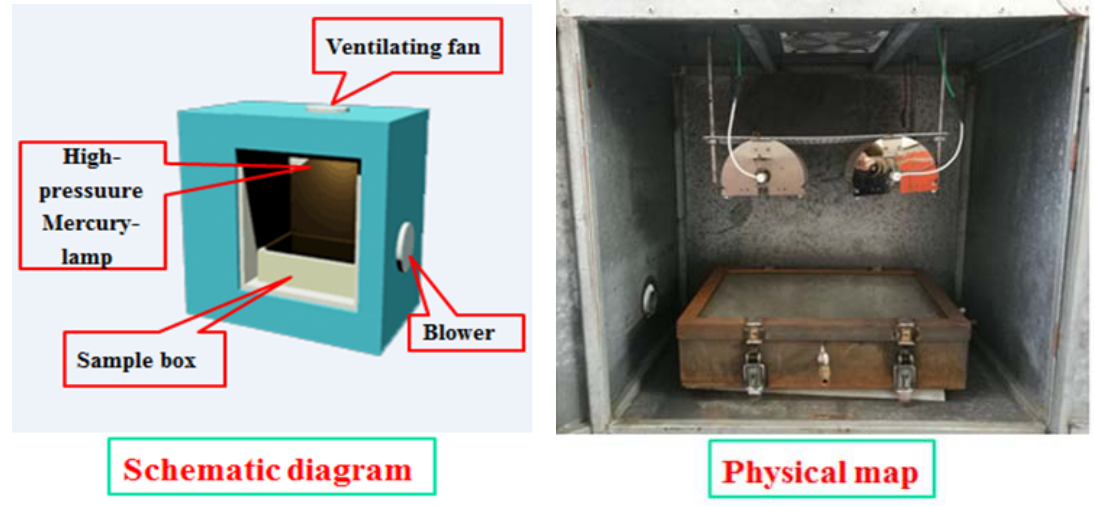
Figure 3. UV and oxygen coupling aging simulation box.